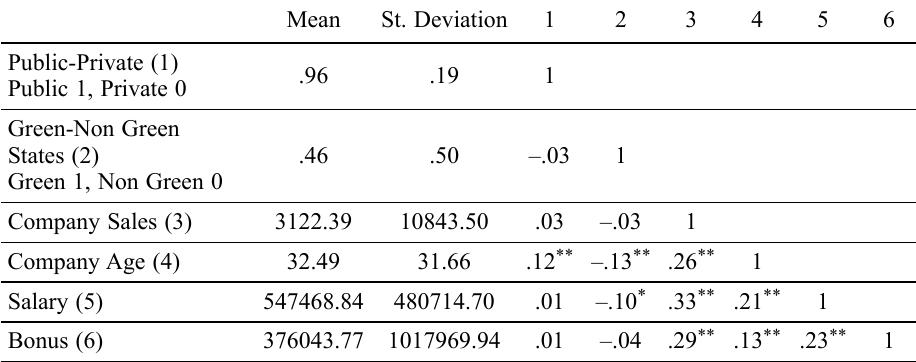
Table 3. Descriptive statistics and correlations (N = 673) Mean St.